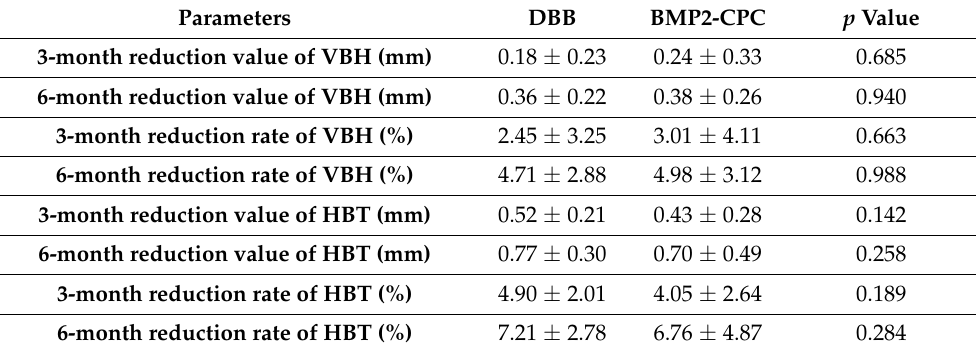
Table 2. Analysis of VBH and